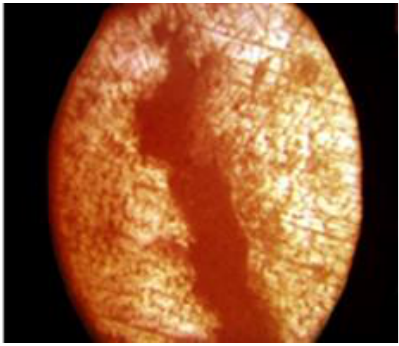
Figure 6. Cracking corrosion.